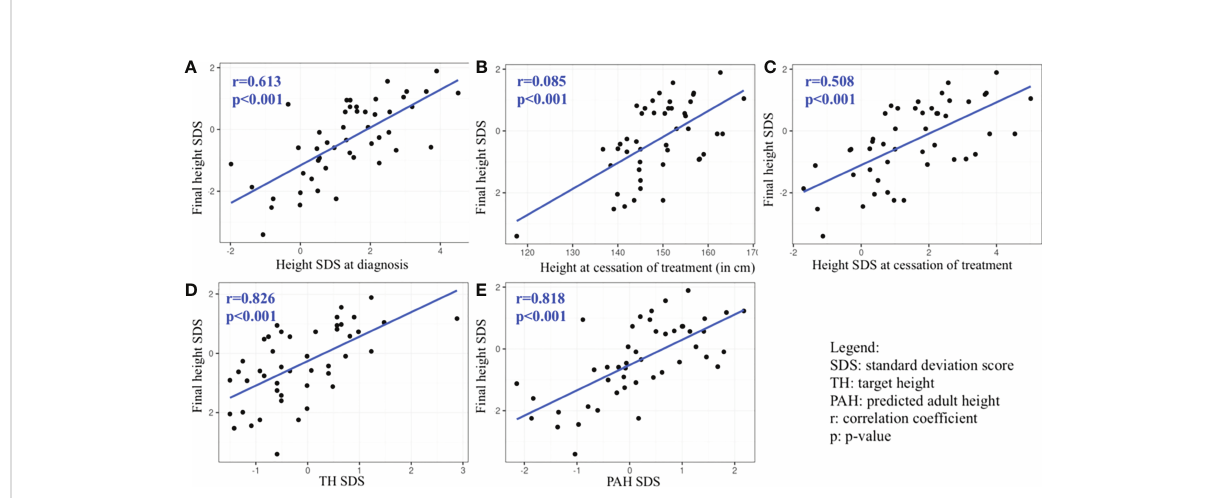
FIGURE 1 Graphs (A – E) : Statistically signi fi cant predictors associated with fi nal height SDS revealed by univariable analysis.